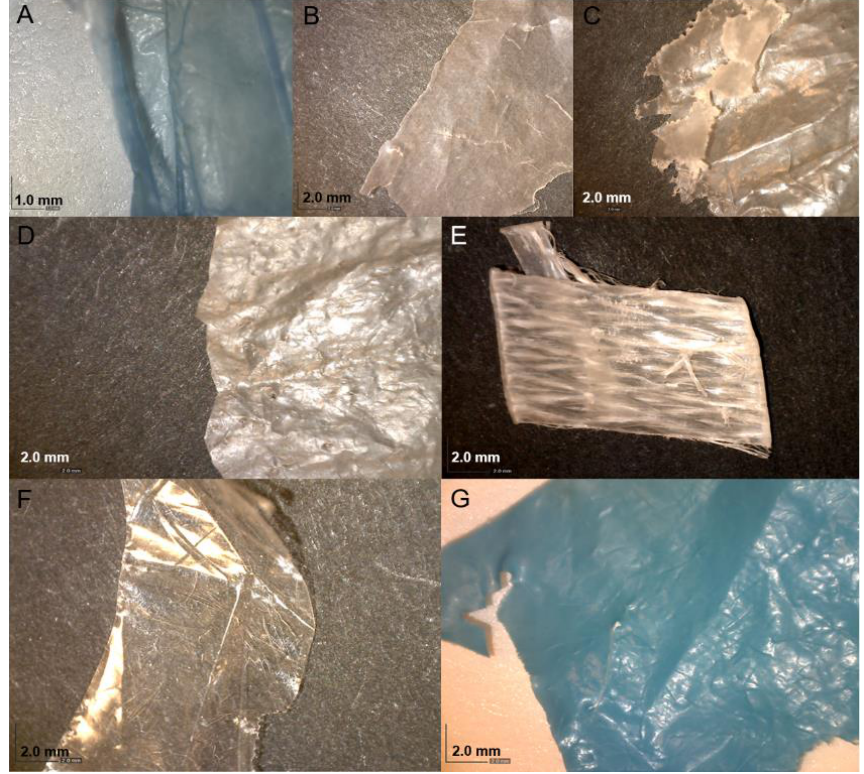
Figure 1. Images of samples collected in this study. ( A , C , D , F , G ) are polyethylene; ( B ) is polyethylene / ethylene vinyl acetate copolymer; ( E , F ) are polypropylene.